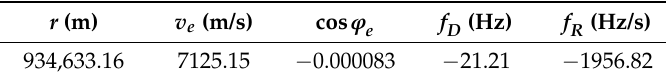
Figure 2. Schemes of hyperbolic range equivalent model (HREM): ( a ) The geometric figure of the HREM; ( b ) The model error between the actual range history and the equivalent range history in the ST experiment. Table 2. Some parameters of acquisition